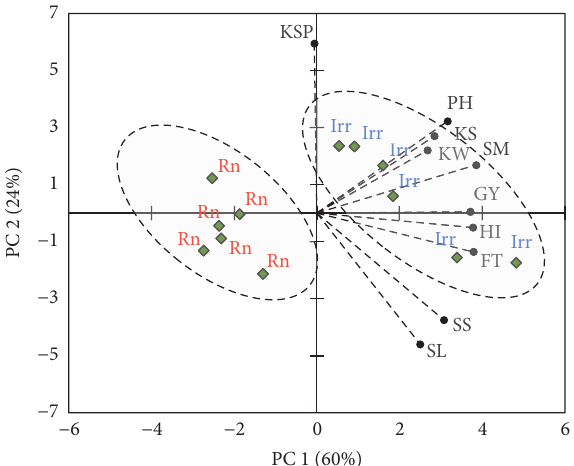
Figure 2: PCA projections on axes 1 and 2 accounting for 84% of total variance. Eigenvalues of the correlation matrix are symbolized as vectors representing traits that most influence each axis. The 12 points representing traits means for each water regime (rainfed (Rn) and irrigated (Irr)) are plotted on the plane determined by axes 1 and 2. Grain yield (GY), spikes per m 2 (SM), kernels per spike (KS), kernel weight (KW), harvest index (HI), spikelets per spike (SS), kernels per spikelet (KSP), fertile tillering (FT), plant height (PH), and spike length (SL).